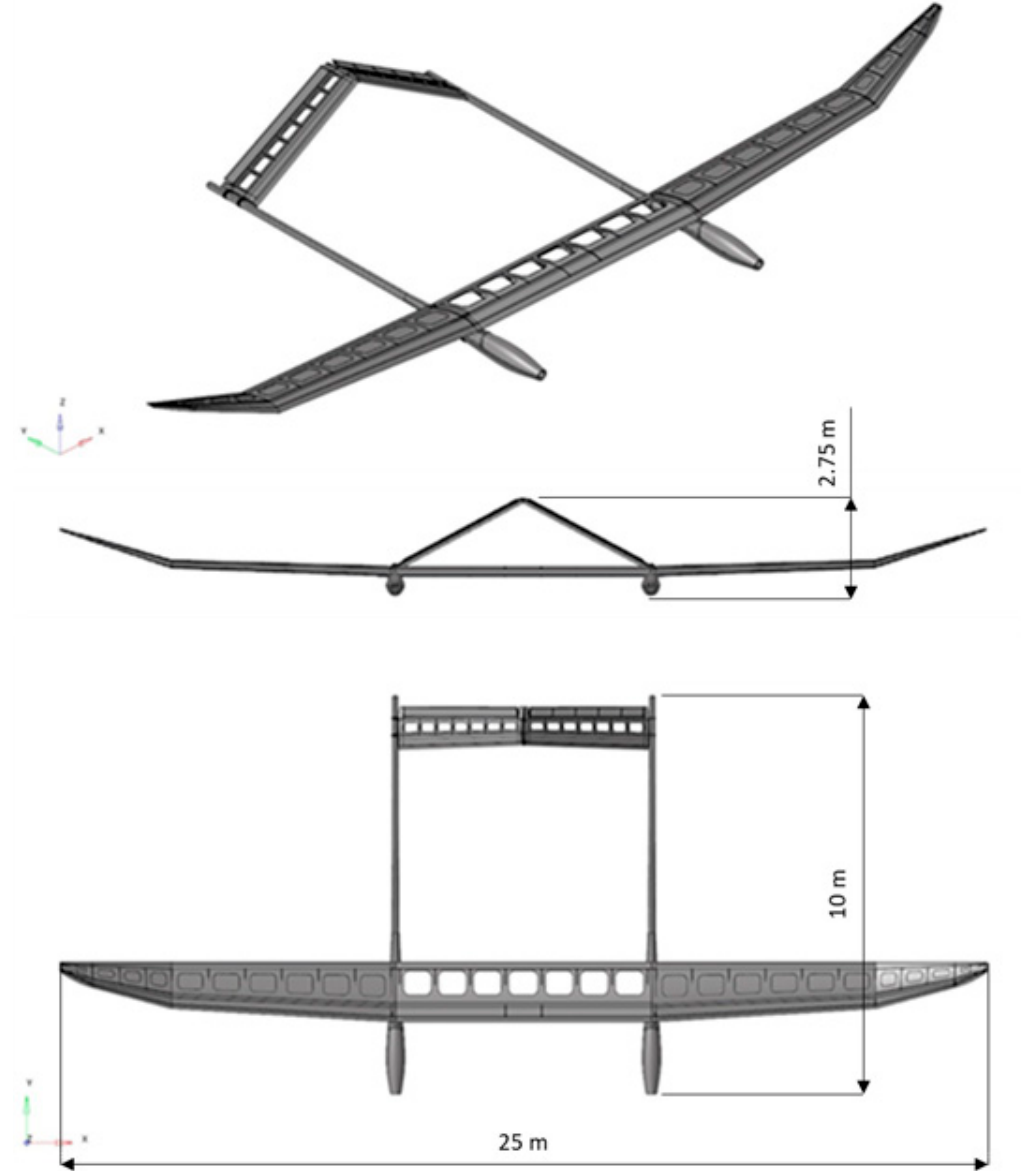
Figure 13. The CAD model prepared for the FEA analysis.